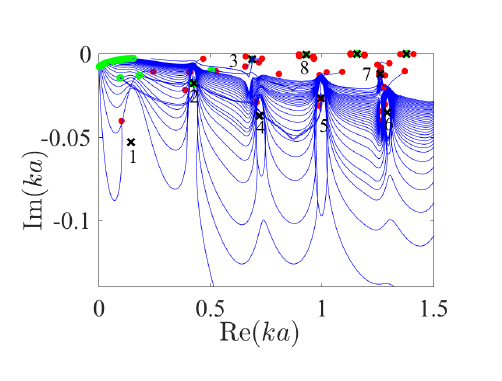
Figure 3: The behavior of resonant frequencies vs the dis- tance between cylinders. Open green circles correspond L = 1000 a , closed red circles correspond to minimal dis- tance L = 2 a , where a is the radius of cylinders and black crosses are the Mie resonances shown in the next Fig.